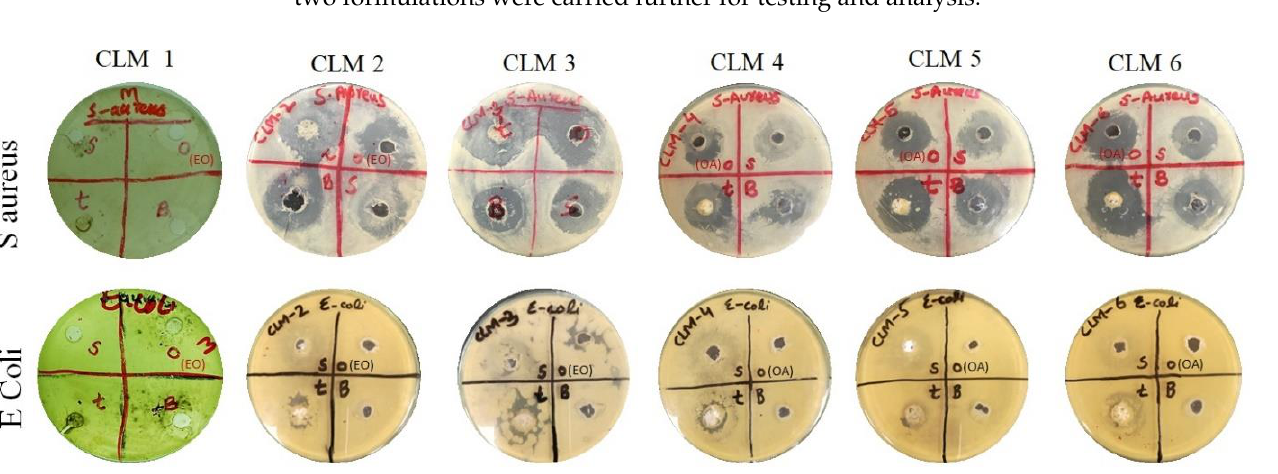
Figure 4. Antibacterial assays of all formulations against S. aureus and E. coli bacteria. In this figure, ‘t’ represents microbeads, ‘s’ represents the standard drug (clarithromycin), ‘o’ represents the tested oil (either eucalyptus oil (EO) or oleic acid (OA)), and ‘B’ represents the blank (0.1 N HCl).